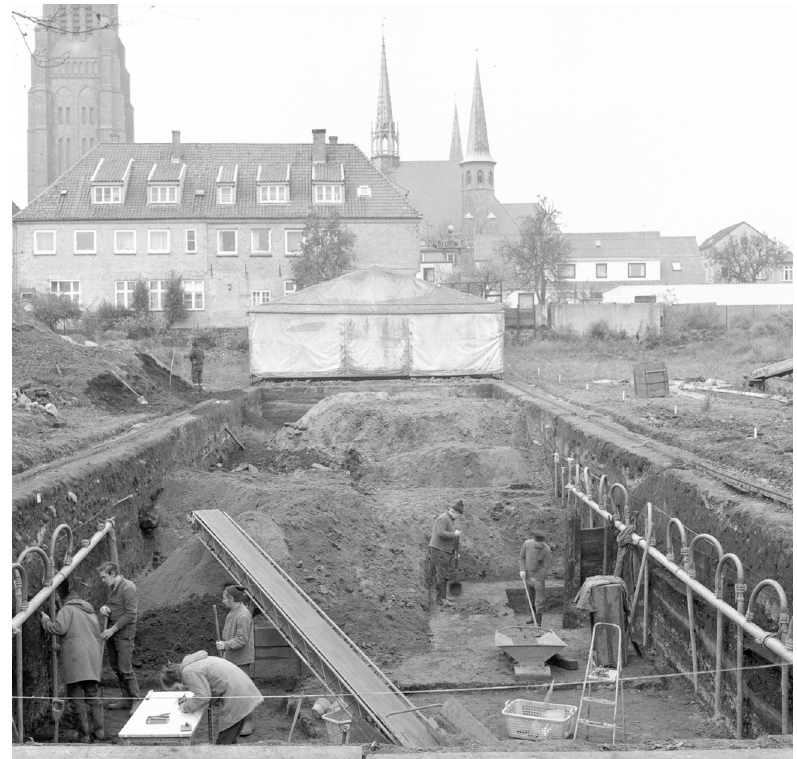
Figure 5: Workers and the draftsman in trench 10 in front of a mobile tent in the second half of the 1970s. In the background, the St. Petri cathedral is visible ( Archive of the Archaeological Museum Schloss Gottorf )